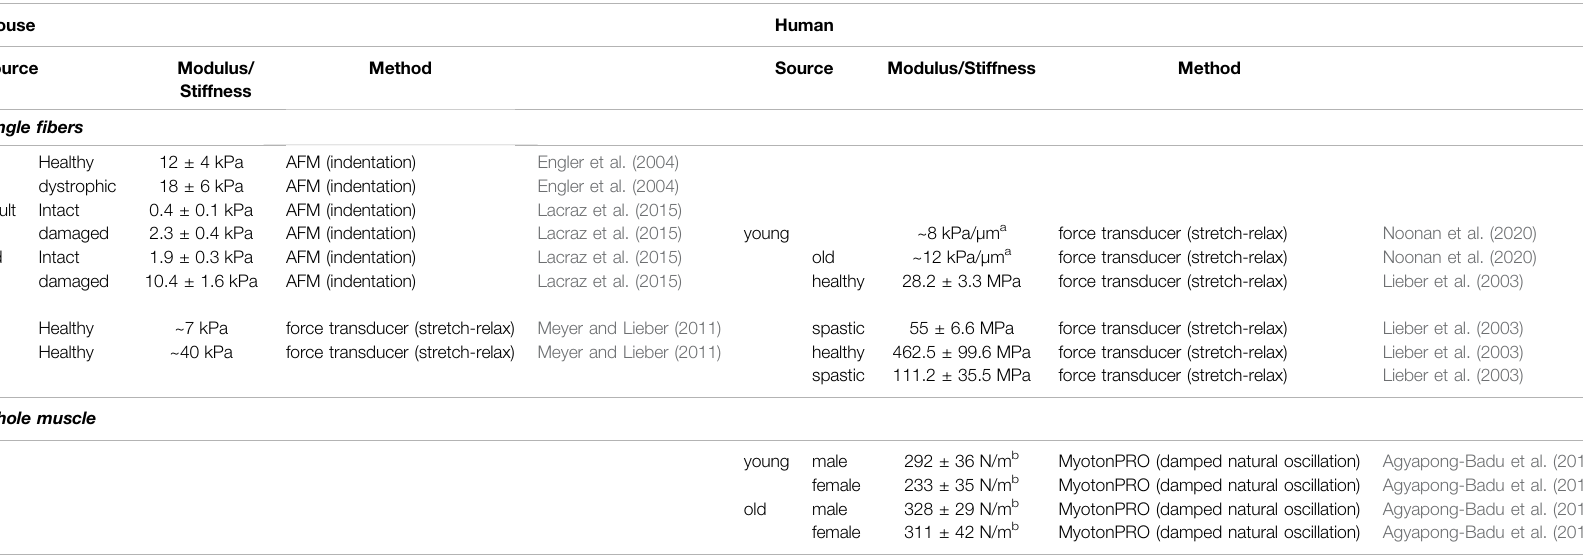
TABLE 1 | Overview of mechanical properties of skeletal muscle in mice and humans.